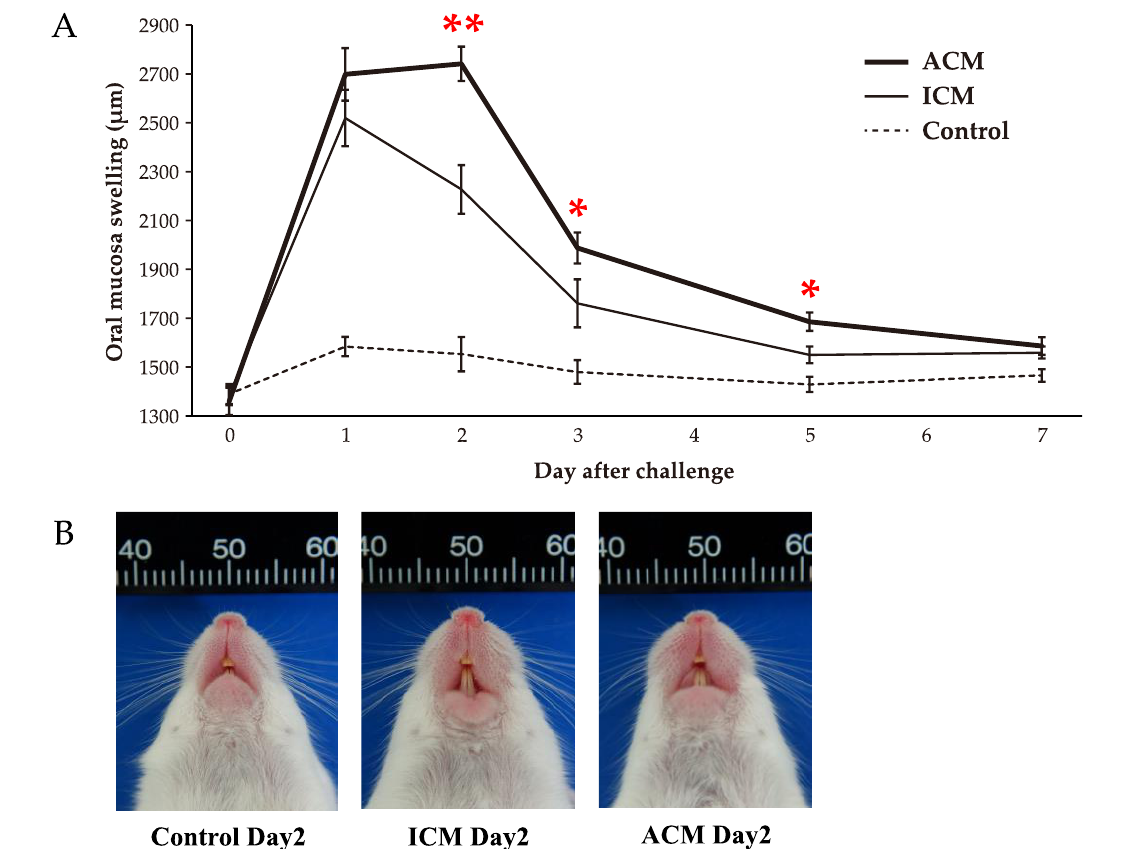
Figure 1. Swelling of the OM in Pd–induced allergic mice. ( A ) OM buccal area swelling from day 1 to day 7 after the challenge was measured in Pd–induced ACM and ICM and control mice ( n = 10). Each point and error bars indicate the mean values and standard deviations. Statistical significance was tested through the Kruskal–Wallis test followed by Steel–Dwass’s multiple comparison tests (* p < 0.05, ** p < 0.01). ( B ) Macroscopic findings of the oral mucosa in Pd–induced allergic mice.